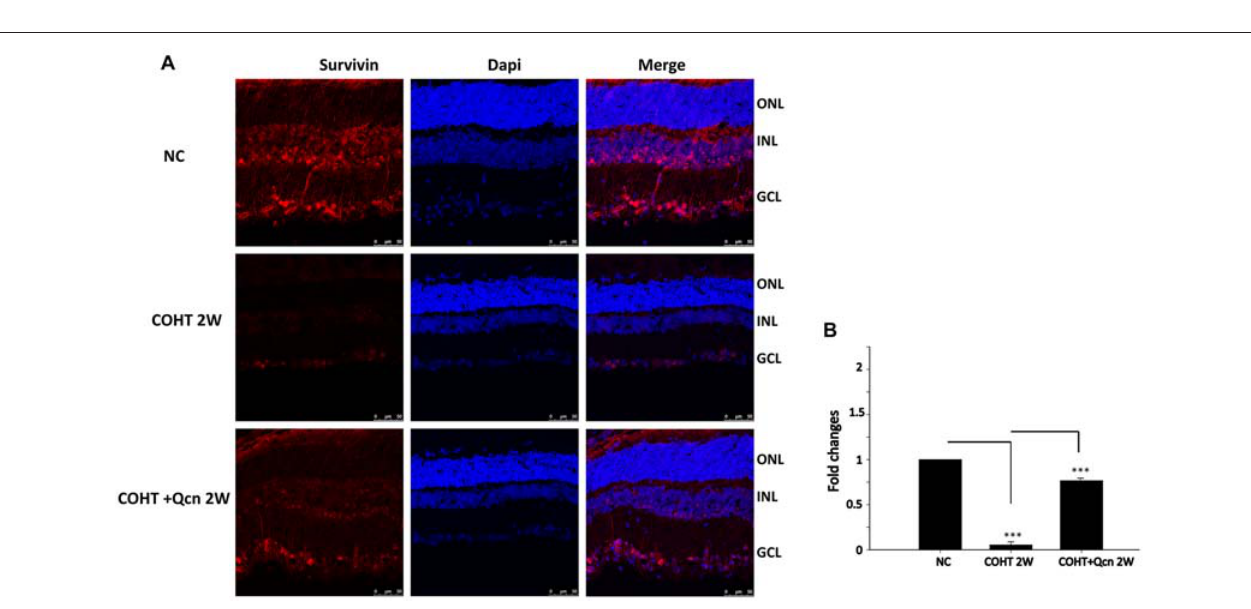
FIGURE 5 | (A) Immunofluorescence of survivin staining (red) of retinas from three different groups at 2 weeks after microbead injection. The NC group (top), COHT (middle) and COHT+Qcn group (bottom). Red indicates positive survivin staining; blue indicates DAPI; GCL, retinal ganglion cell layer; INL, inner nuclear layer; and ONL, outer nuclear layer. Scale bar, 50 µ m. (B) Quantitative analysis of survivin-positive regions in retinas from different treatment groups. The data are presented as the mean ± SD, ∗∗∗ p <